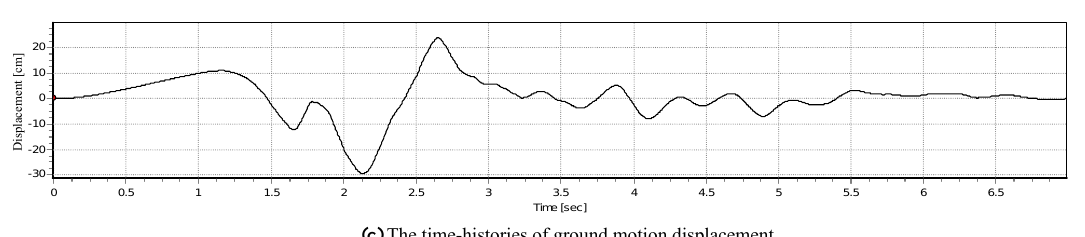
(c) The time-histories of ground motion displacement Fig.2. Acceleration (a) velocity (b) and displacement (c) time-histories for near-fault ground motion recorded at Yarimca in Kocaeli earthquake